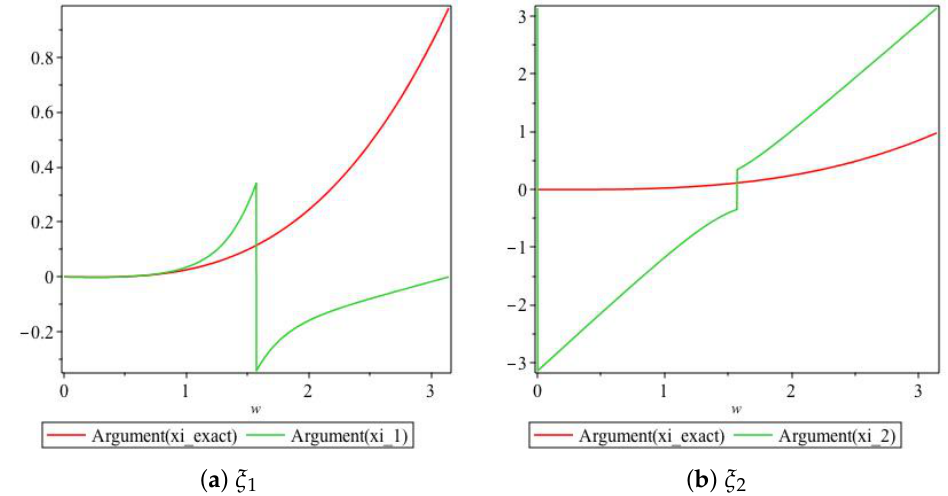
Figure 15. Plot of the arguments of amplification factors of Scheme 3 for Numerical Experiment 1 with the spatial and temporal step sizes h = π /10 and k = 0.001,